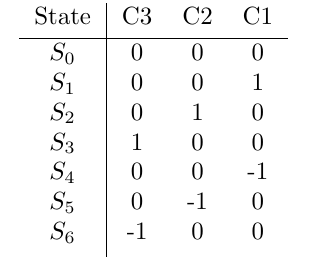
Table 1: Table of allowed states for the three cylinders